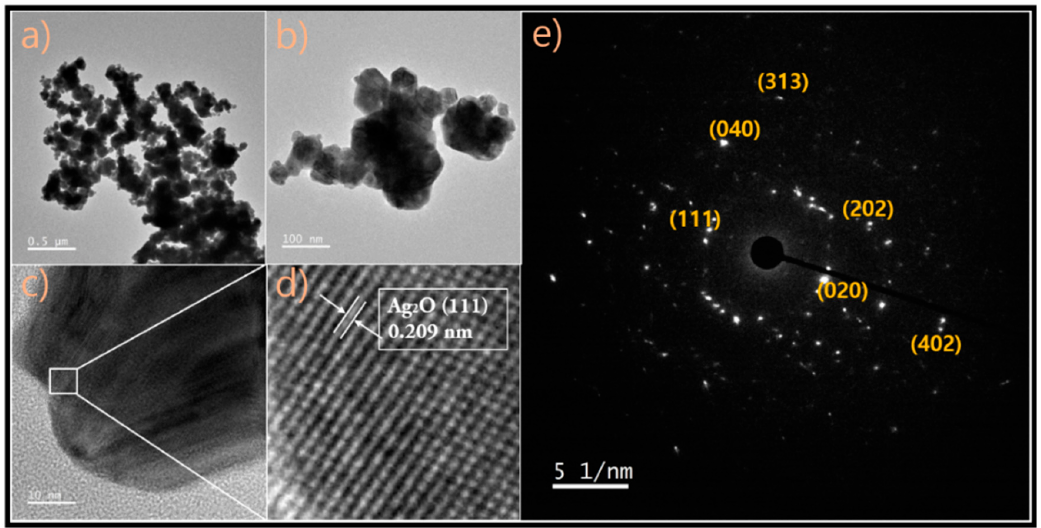
Figure 4. TEM images of synthesized Ag 2 ONP: ( a ) low-magnification TEM image of Ag 2 ONP; ( b ) high-magnification TEM image of Ag 2 ONP; ( c ) high-resolution (HR)TEM image of Ag 2 ONP; ( d ) lattice spacing of Ag 2 ONP; ( e ) SAED pattern image of Ag 2 ONP.